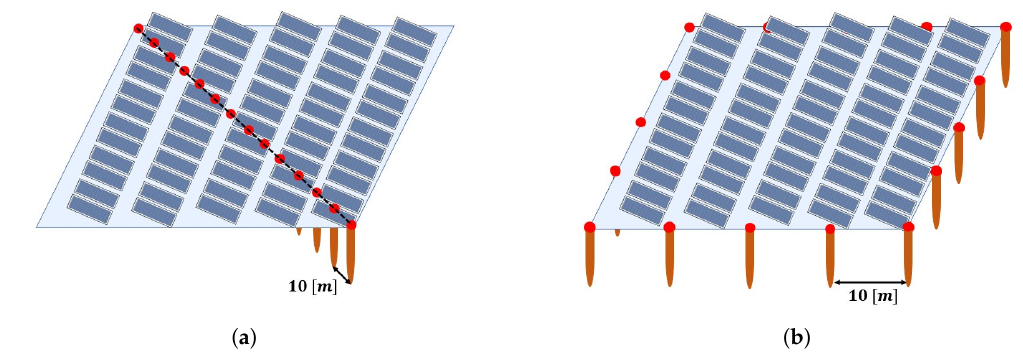
Figure 12. Arrangement of electrodes in a 100-kW floating PV system: ( a ) linear type ( b ) and quadrangle